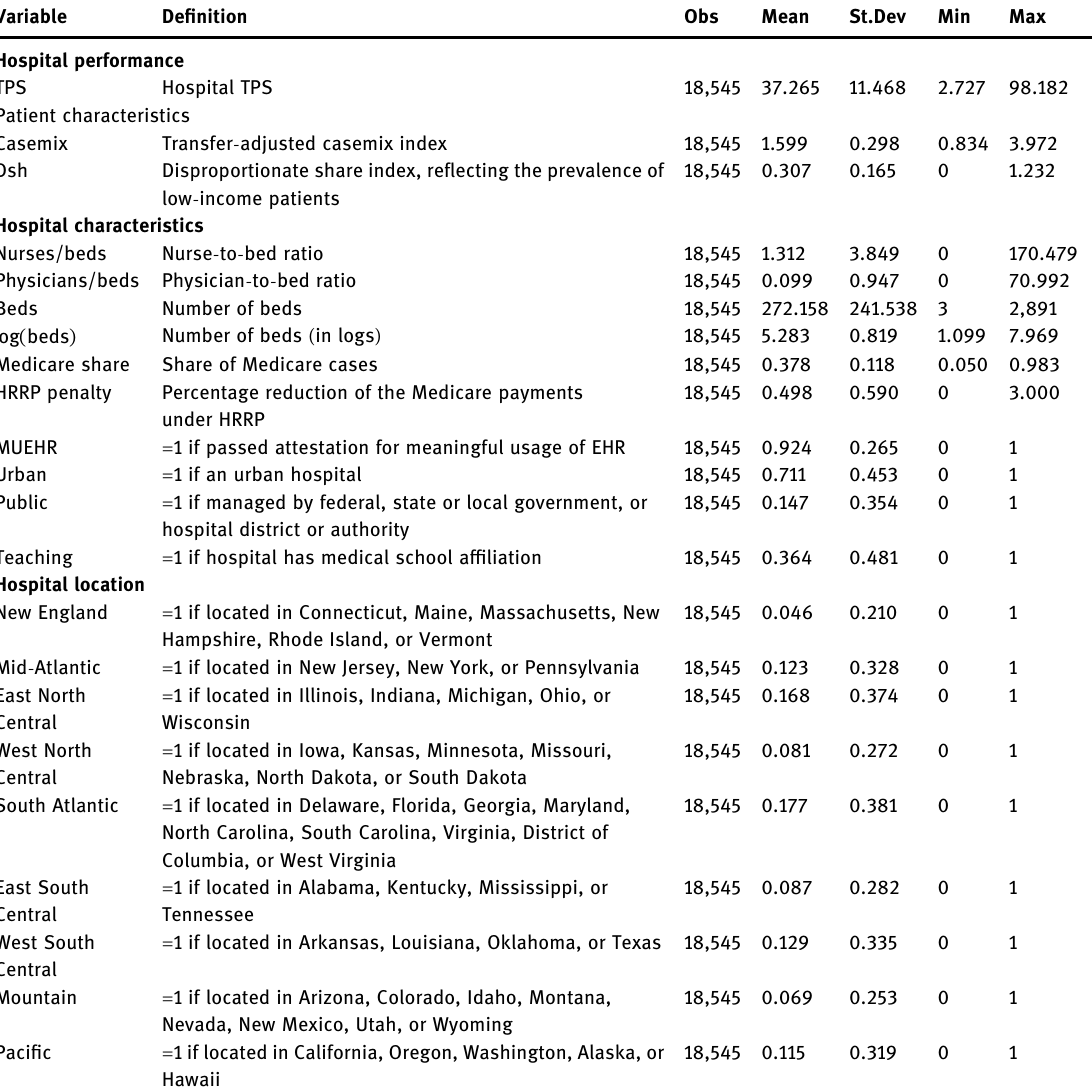
Table 1: Descriptive statistics for Medicare ’ s acute - care hospitals in 2013 –